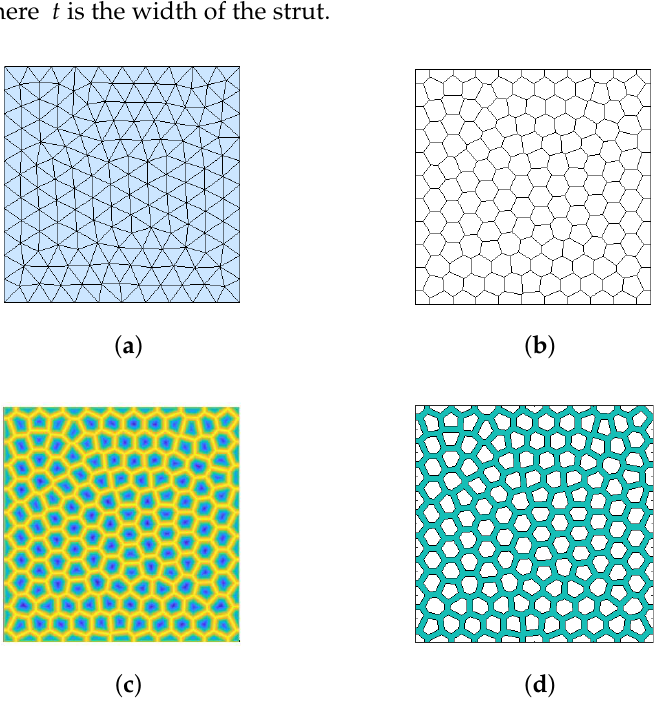
Figure 2. Generation of the stochastic Voronoi microstructure: ( a ) the skeleton in the triangle diagram; ( b ) the skeleton in the Voronoi diagram; ( c ) the signed distance function; ( d ) the generated Voronoi